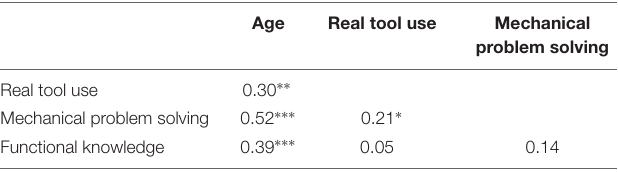
TABLE 4 | Correlations according to whole sample ( n = 85) between real tool use, mechanical problem-solving and functional knowledge. Age Real tool use